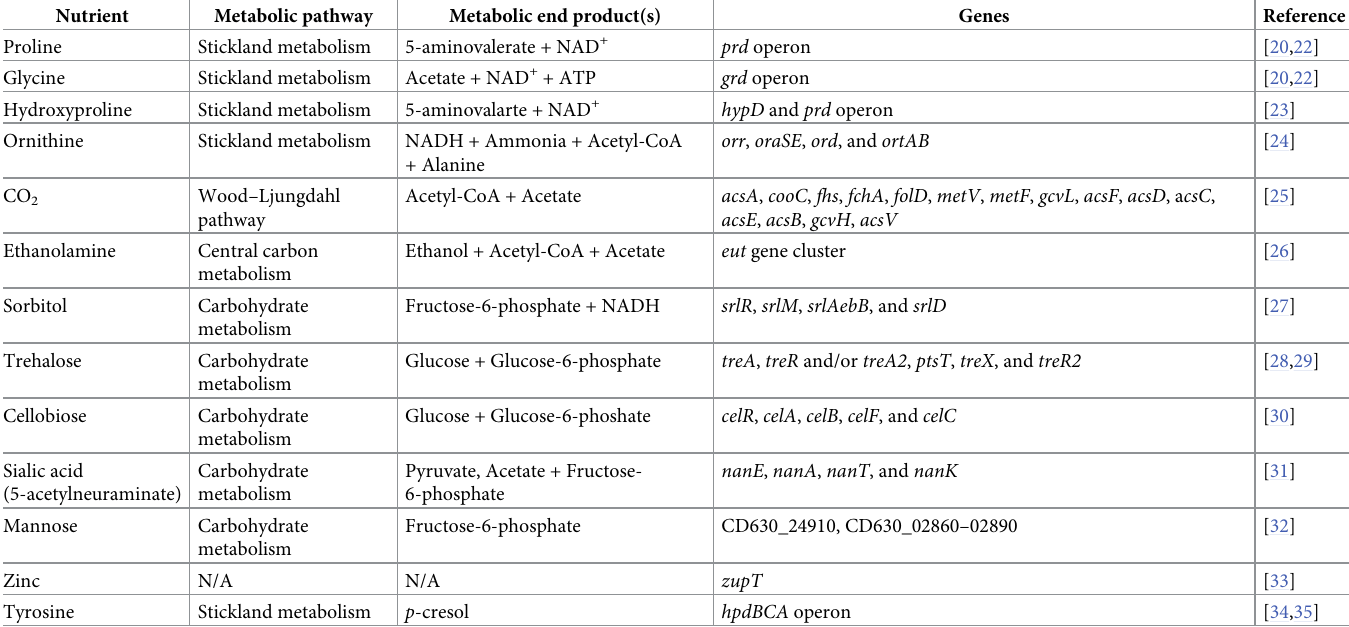
Table 1. Nutrients of interest utilised by C . difficile during gut